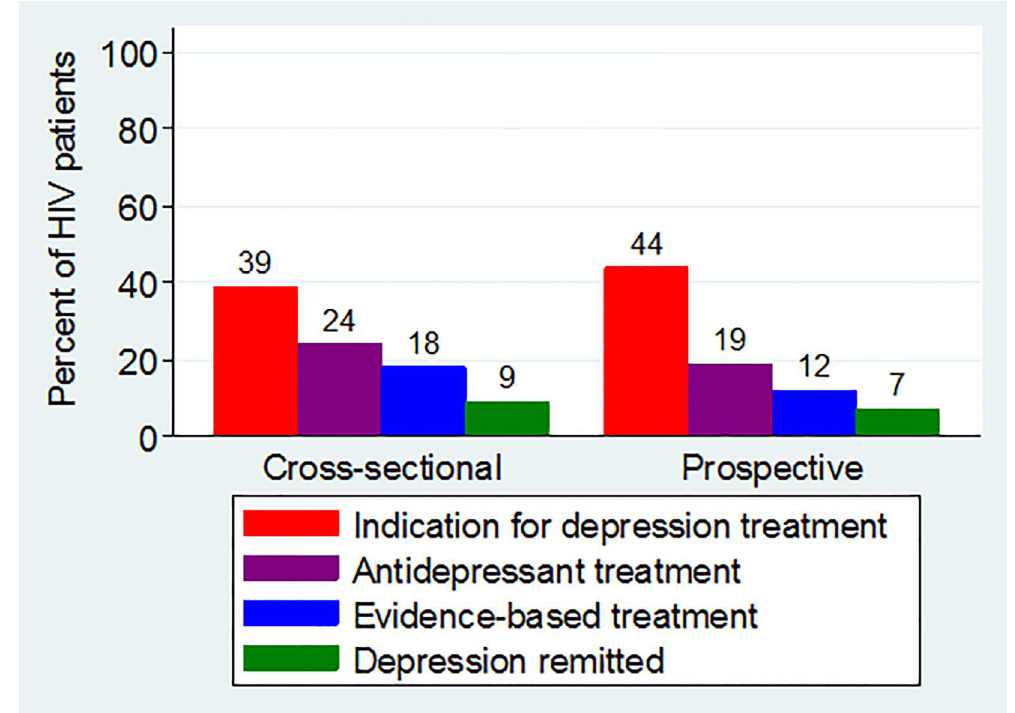
Fig 3. The depression treatment continuum for patients engaged in HIV primary